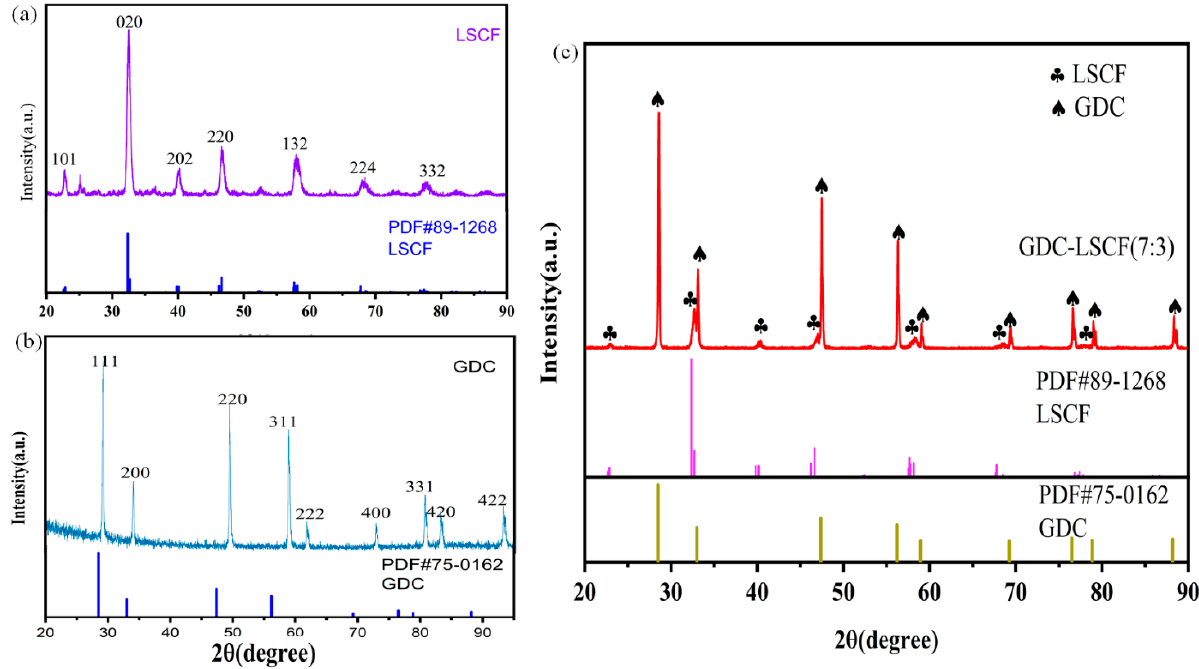
Figure 1. ( a – c ) X-ray di ff raction pa tt erns of synthesized LSCF, GDC, and heterostructure composites of LSCF-GDC, respectively. of LSCF-GDC,